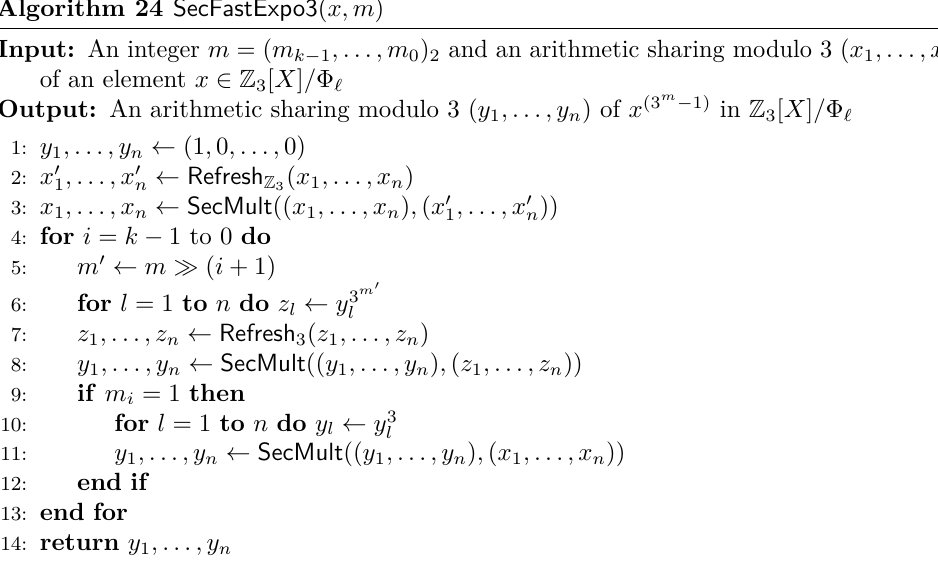
Algorithm 24 SecFastExpo3 ( x, m